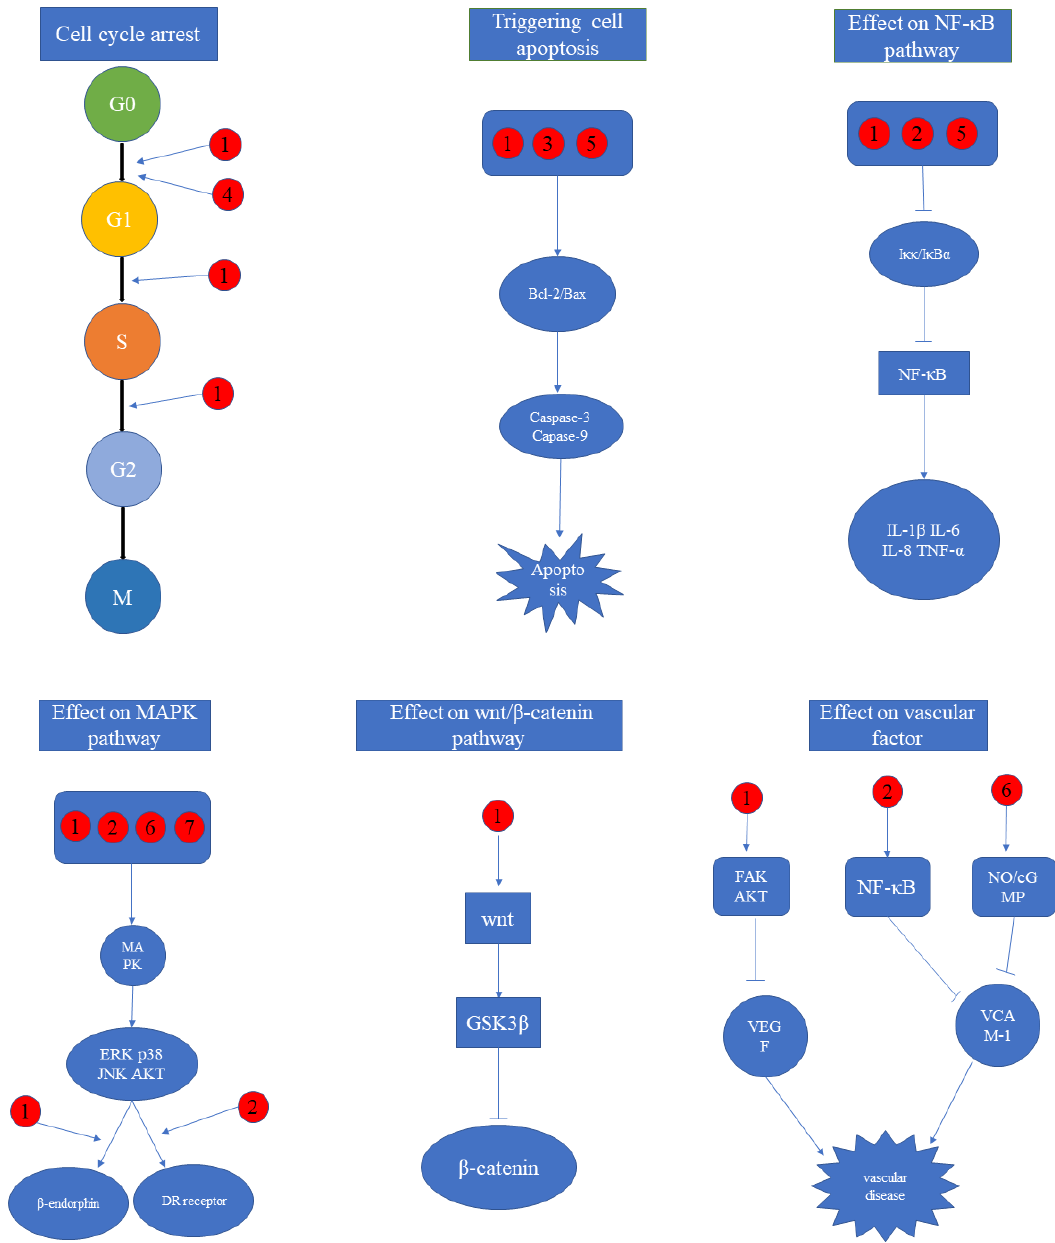
Figure 7. Representative molecular mechanism of bioactive compounds and extracts isolated from CA , CB and CW. (Bioactive constituents: 1 (cid:13) : Caudatin, 2 (cid:13) : Cynandione A, 3 (cid:13) : Wilfoside C3N, 4 (cid:13) : Auriculoside A, 5 (cid:13) : C 21 steroidal glycoside of CA , 6 (cid:13) : Ethanol extract of CW , 7 (cid:13) : Polysaccharide of CW ).